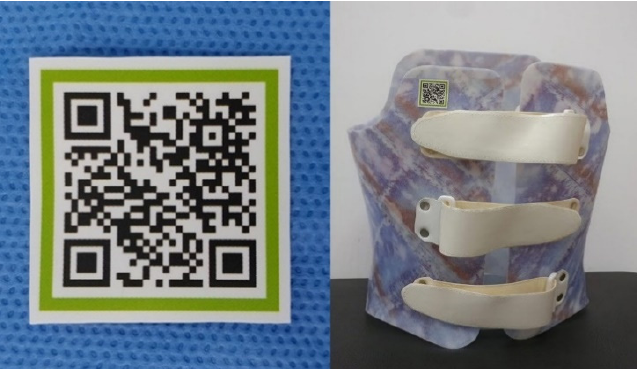
Figure 1. The QR code was distributed in the form of a business card-sized print and sticker and the sticker was attached to the brace.